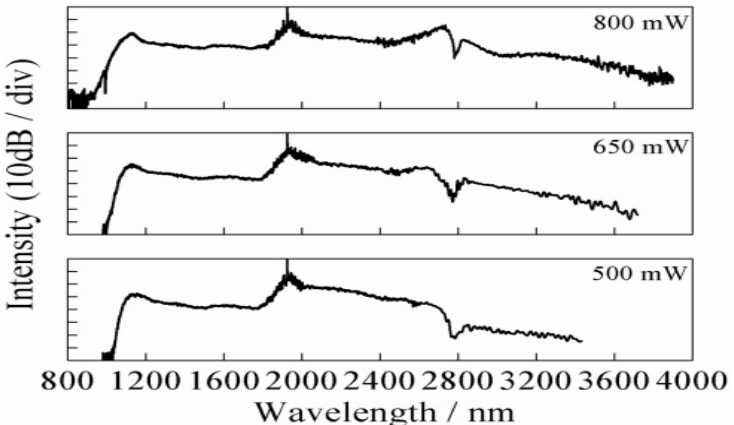
Figure 9. Measured SC in a tellurite microstructured optical fiber (MOF) at the pump wavelengths of ~1958 nm with average pump powers of ~500, 650, and 800 mW. With the average pump power increasing to ~800 mW, the broadband mid-infrared SC generation with the spectrum from ~900 to 3900 nm is observed. Reprinted with permission from [54] © The Optical Society.